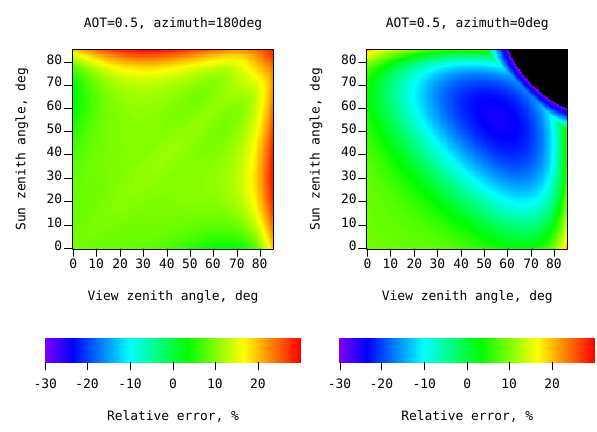
Fig. 6. Relative errors of the reflectance from layer “1” at the layer optical thickness equal to